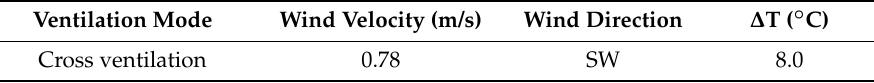
Table 5. Local weather conditions during test of room air temperature profile (plane 2).